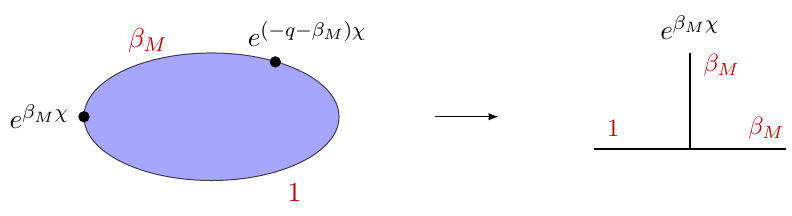
Figure 5 . Matter Coulomb gas two-point function with a vacuum brane 1 injected with charge β M to form the state β M -brane and then